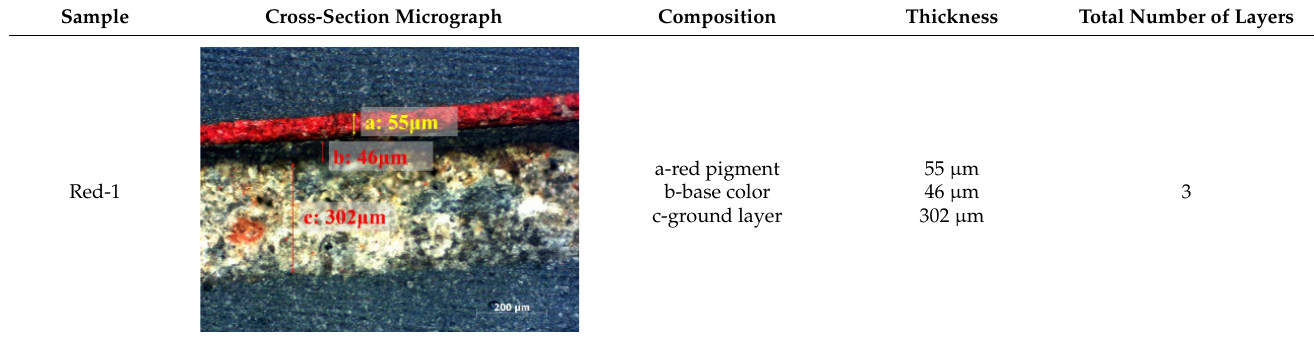
Table 2. Cross-section of a sample acquired by using ultra-depth three-dimensional microscopy.